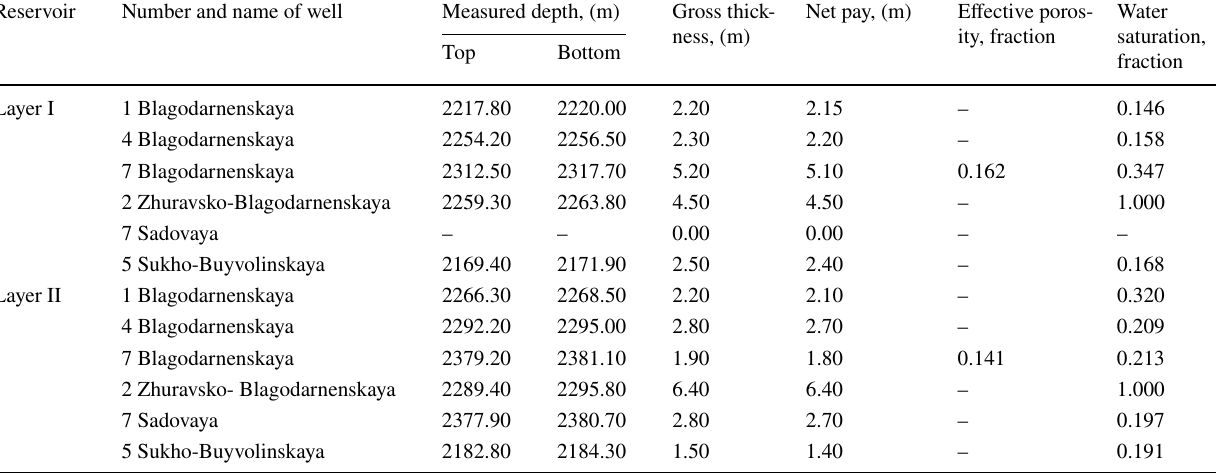
Table 8 Results of wireline logs interpretation for deep-exploration wells of Blagodarnenskaya structure Reservoir Number and name of